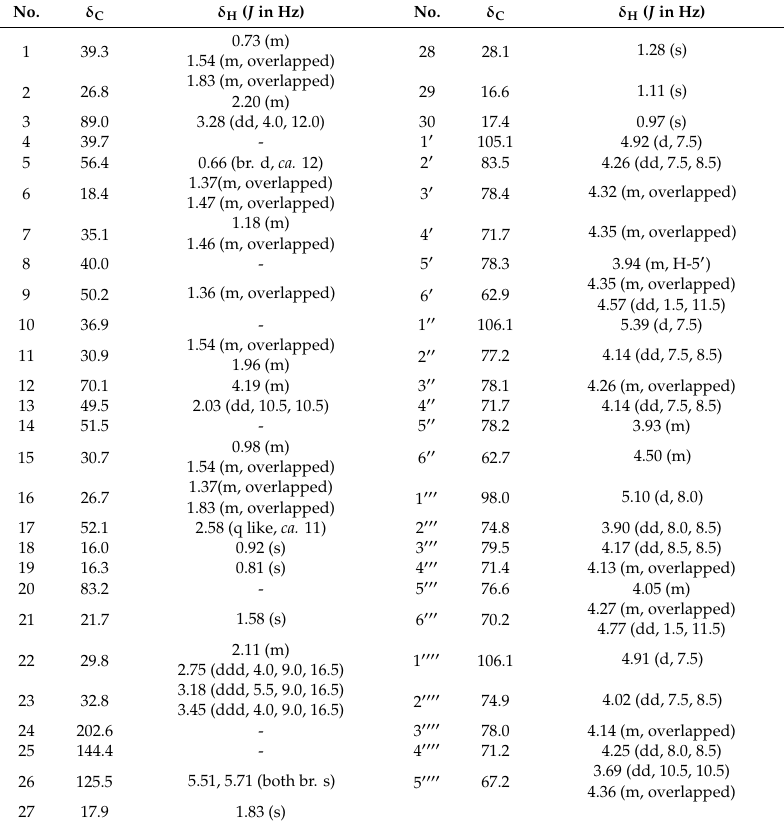
Table 10. The 1 H and 13 C-NMR data for 10 in C 5 D 5